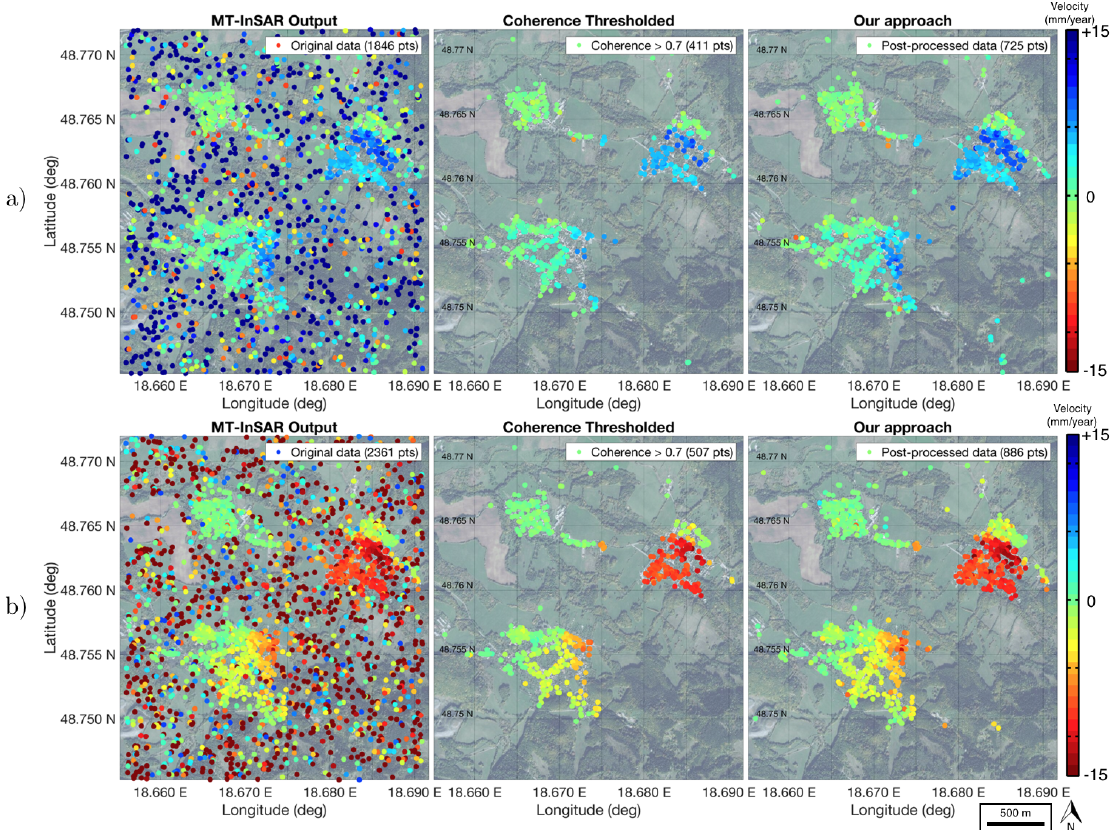
Figure 9. Filtering capabilities of post-processing methodology over area of active landslides in Prievidza disctricts (Hradec, Velka Lehotka): Mean line-of-sight (LOS) velocities from: ( a ) ascending Track No. 175; and ( b ) descending Track No. 51.